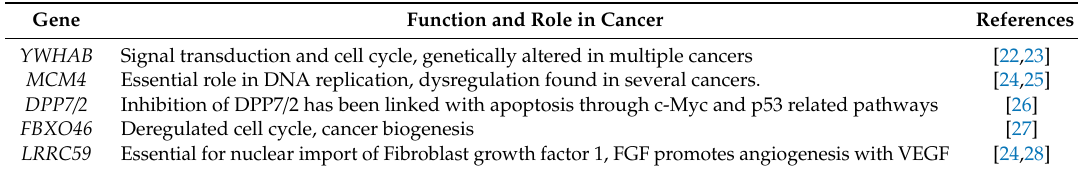
Table 6. Functional relevance of genes that were significantly associated with OS in CRC patients. Gene Function and Role in Cancer